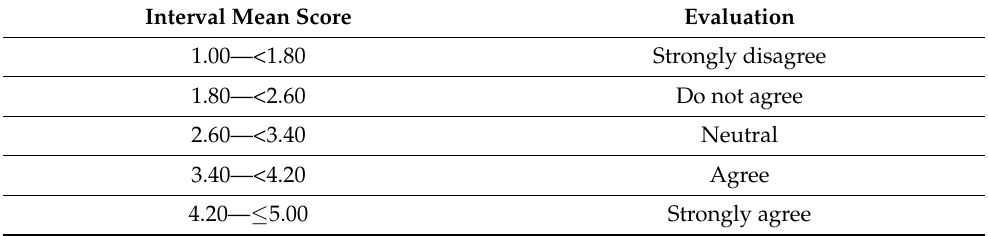
Table 1. Average Interval of Research Variables.